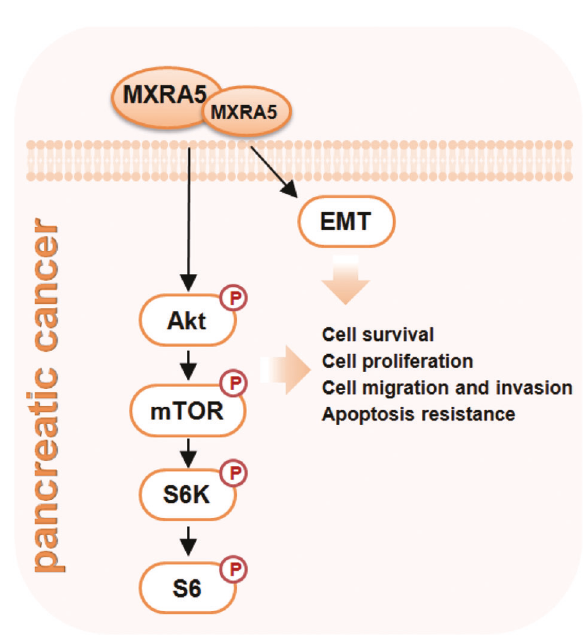
Fig. 9 The proposed signaling carton of the present